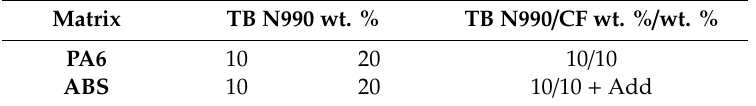
Table 8. Formulation of extruded composites and hybrids containing TB N990 and CF for 3D printing.